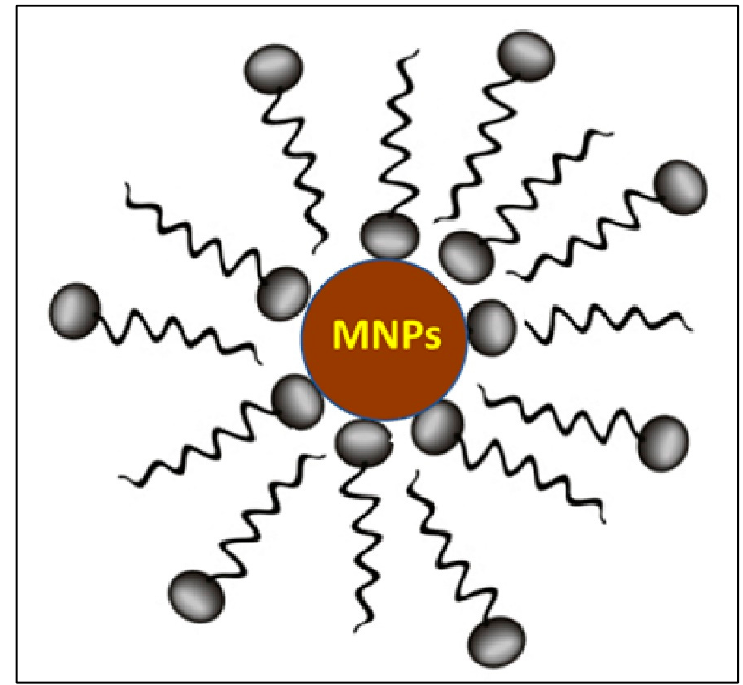
Figure 1. MNPs coated by fatty acid.